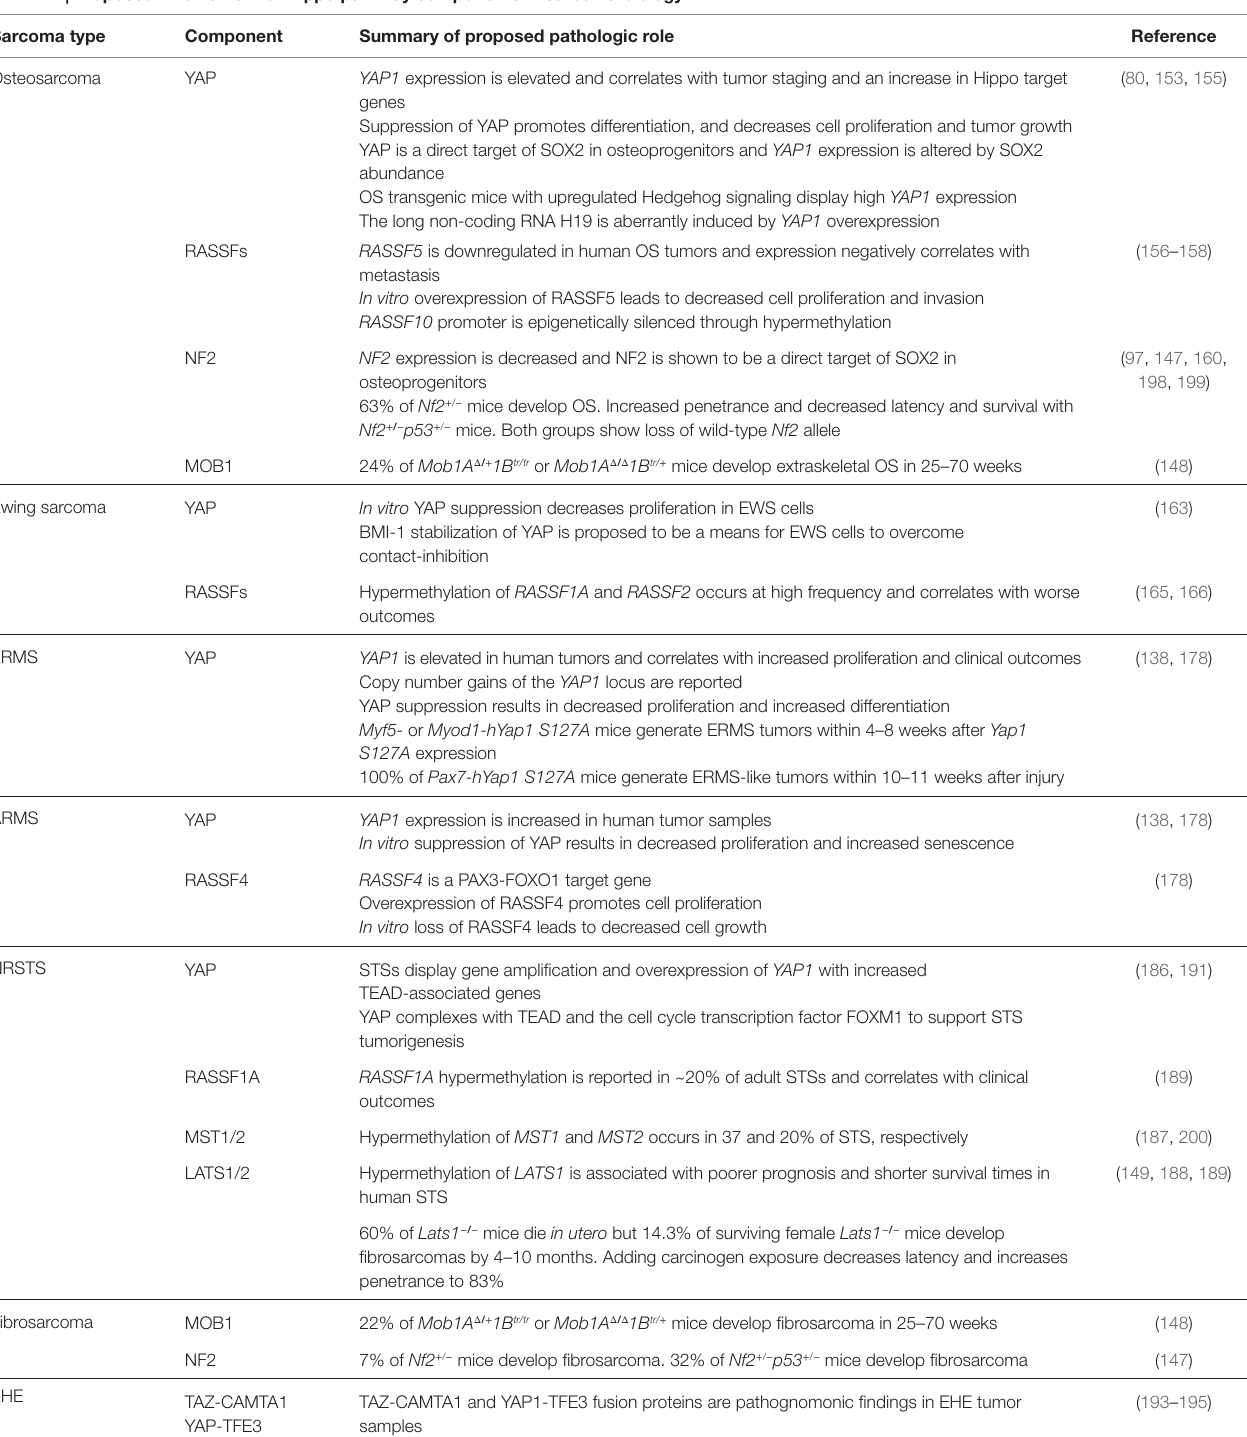
TABLe 2 | Proposed involvement of Hippo pathway components in sarcoma